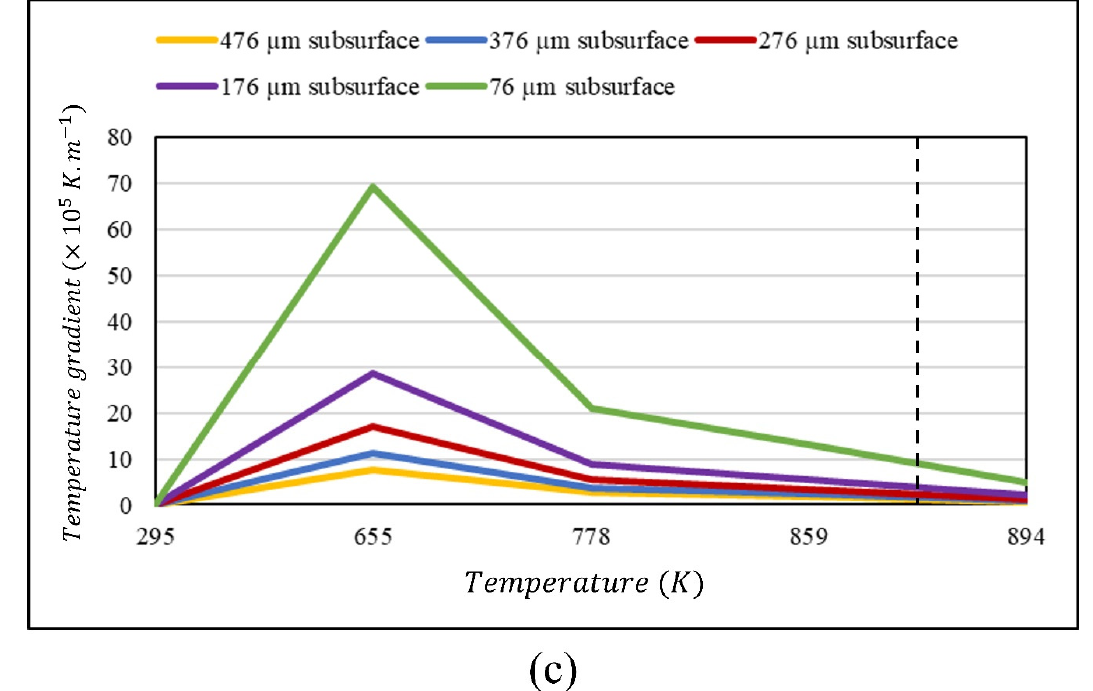
Figure 8. ( a ) Variation of temperature versus welding time for di ff erent points within the molten pool; ( b ) variation of temperature gradient versus welding time for di ff erent points within the molten pool; ( c ) variation of temperature gradient versus temperature for di ff erent points within the molten pool obtained from the numerical modeling using a laser beam with an average power of 80 W, welding velocity of 2 mm · s − 1 , and absorption coe ffi cient of 0.36.